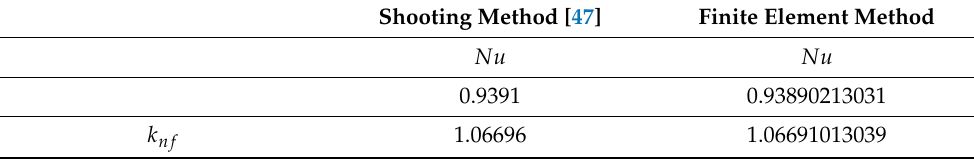
Table 4. Comparative numerical values of Nusselt number with shooting method for